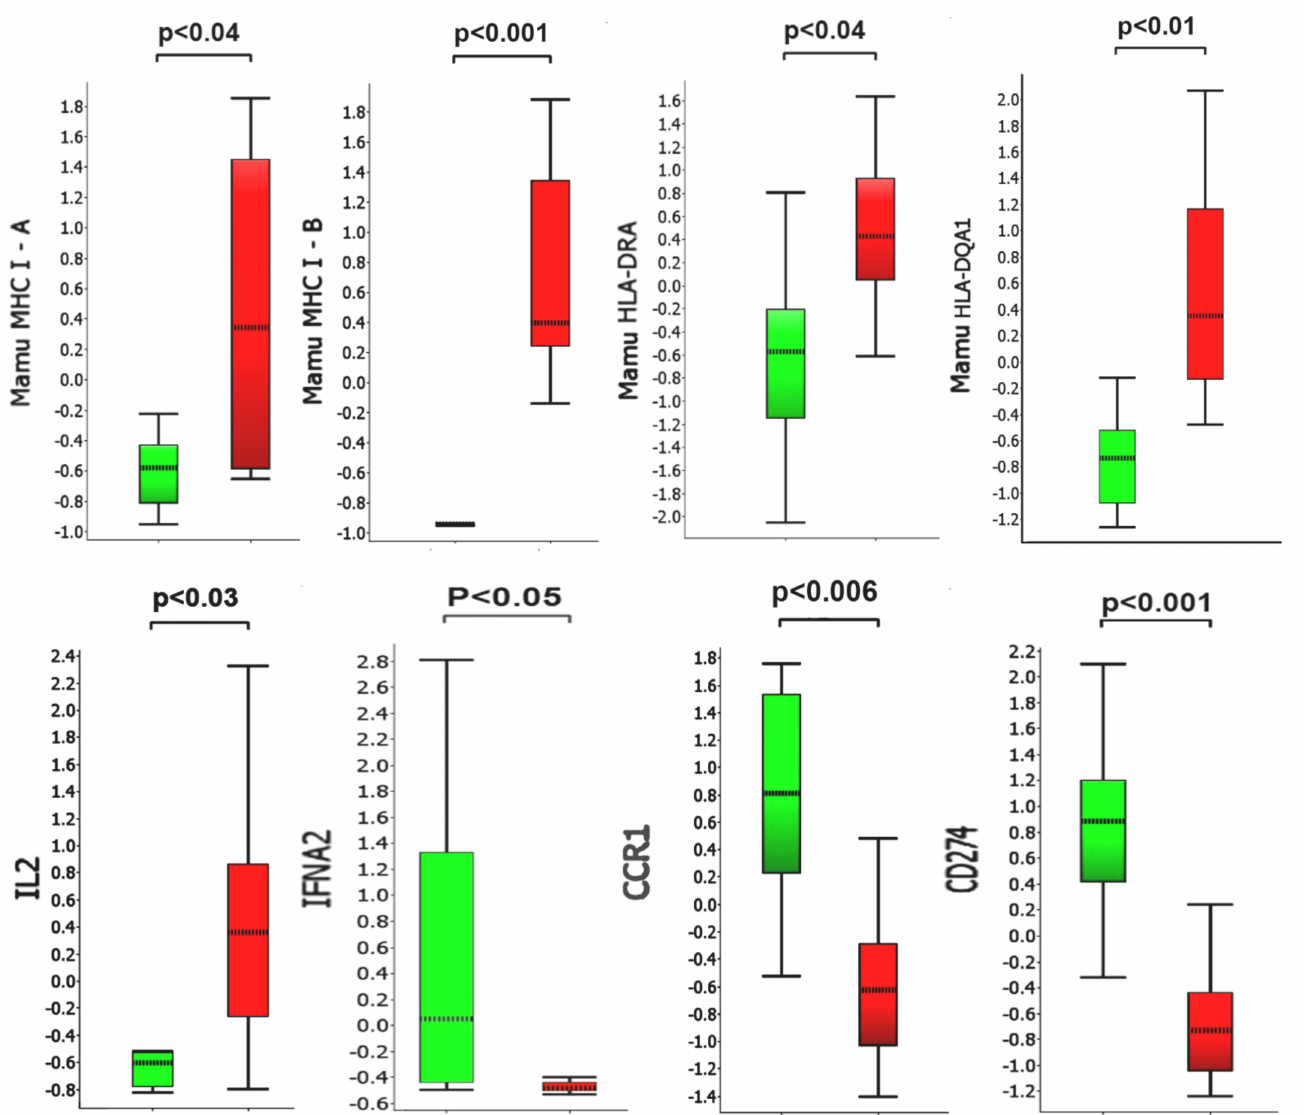
Figure 6. Comparison of selected transcripts up- or downregulated in collected BAL samples 5–7 days post-challenge. Y-axis values represent fold differences in average scaled counts. Green bars and red bars represent control and vaccinated macaques, respectively. p -values below 0.05 were considered